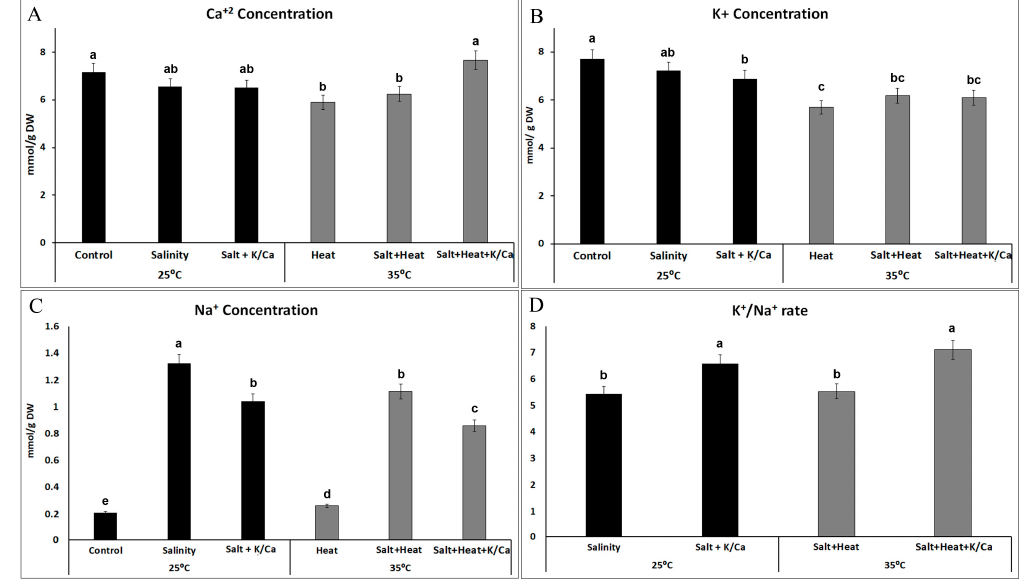
Figure 2. Ca 2 + , K + and Na + concentration ( A – C ) and K + / Na + ratio ( D ) in tomato leaves grown under Figure 2. Ca 2+ , K + and Na + concentration ( A–C ) and K + /Na + ratio ( D ) in tomato leaves grown under control, salinity (60 mM NaCl) or salinity combined with higher K + and Ca 2 + concentration in the control, salinity (60 mM NaCl) or salinity combined with higher K + and Ca 2+ concentration in the irrigation solution under optimal temperature (25 ◦ C) or under heat stress (35 ◦ C). Values represent irrigation solution under optimal temperature (25 °C) or under heat stress (35 °C). Values represent means ± SE ( n = 6). Bars with di ff erent letters represent data with significant di ff erences at p < 0.05 means ± SE ( n = 6). Bars with different letters represent data with significant differences at p < 0.05 (Tukey (Tukey HSD).